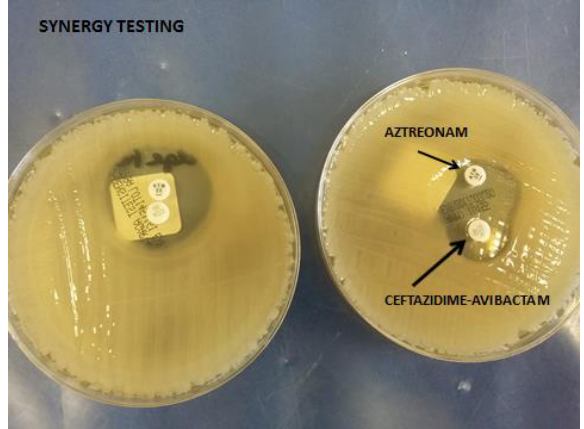
Figure 1. Positive Synergy Test. “Russian-doll” appearance implies synergy between Ceftazidime- avibactam and Aztreonam. When used in combination these agents can be used synergistically to cover both serine (Ceftazidine-avibactam) and metallo (Aztreonam)